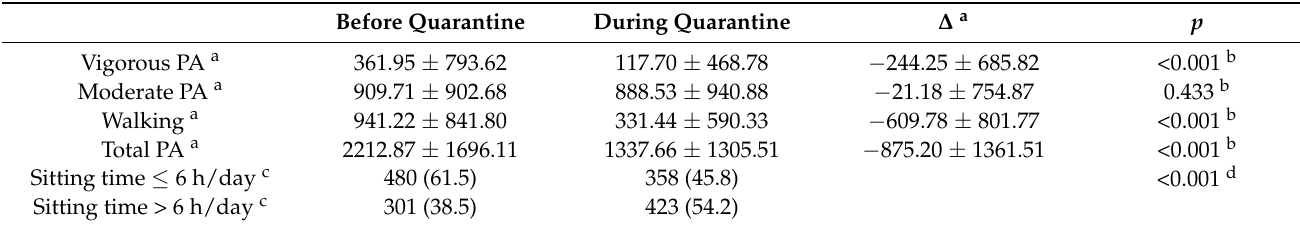
Table 5. Level (MET-min/week assessed with IPAQ-SF score) and time sitting/lying (h/day) before and during nearly two months of quarantine.